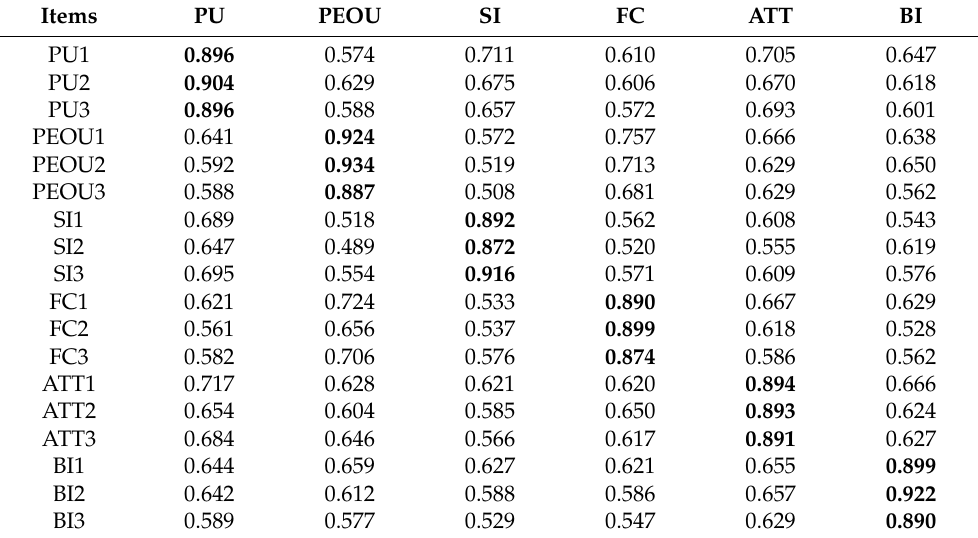
Table 5. Discriminant Validity (Cross-Loadings).